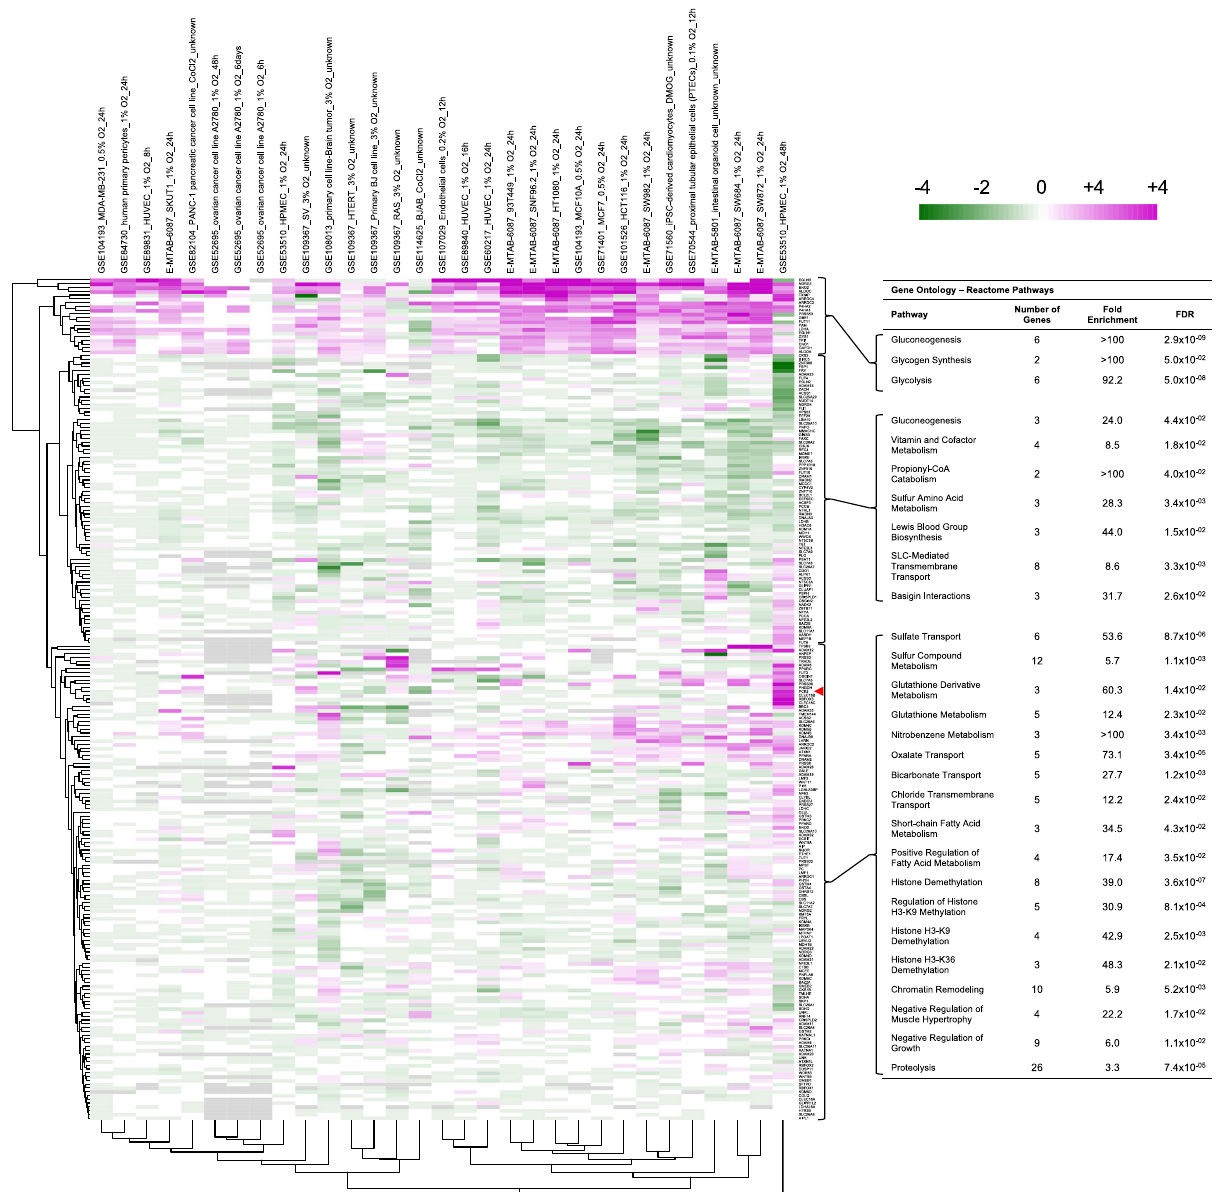
Fig.5|DifferentialgeneexpressionforhumanorthologsofHIF-1directtargets across multiple independent experiments. Heatmap of mRNA expression across 31 independent experiments (columns, including accession numbers and hypoxia treatment indicated in vertical names) involving HIF1A activation. Fold change in expression (expressed as log2) is mapped for individual human orthologs (rows) of the C. elegans HIF-1 direct targets identi fi ed in this study. Only genes showing expression in at least 15 experiments are shown. Genes with similar patterns of expression across experiments are hierarchically